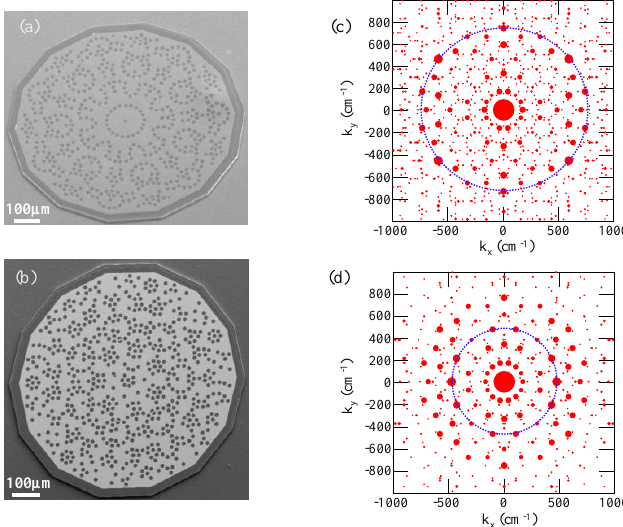
Figure 2. ( a ) Scanning electron microscope (SEM) image of one of the fabricated type A resonators, with a hole radius r = 8.0 µm, average intersite distance a = 29.9 µm and area 0.53 mm 2 ; ( b ) SEM image of one of the prototype type B resonators, with r = 7.5 µm, a = 30.0 µm and area 0.53 mm 2 ; ( c , d ) Form factor S(k) of the type A ( c ) and type B ( d ) quasi-crystals. The red spots indicate the reciprocal vectors, with radii proportional to associated squared Fourier coefficients. The blue circles of radius k p show Bragg peaks of S(k) responsible for vertical extraction.